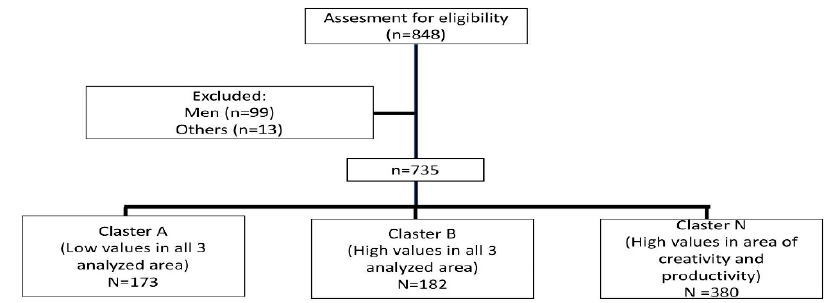
Figure 1. The process of investigation and data analysis.